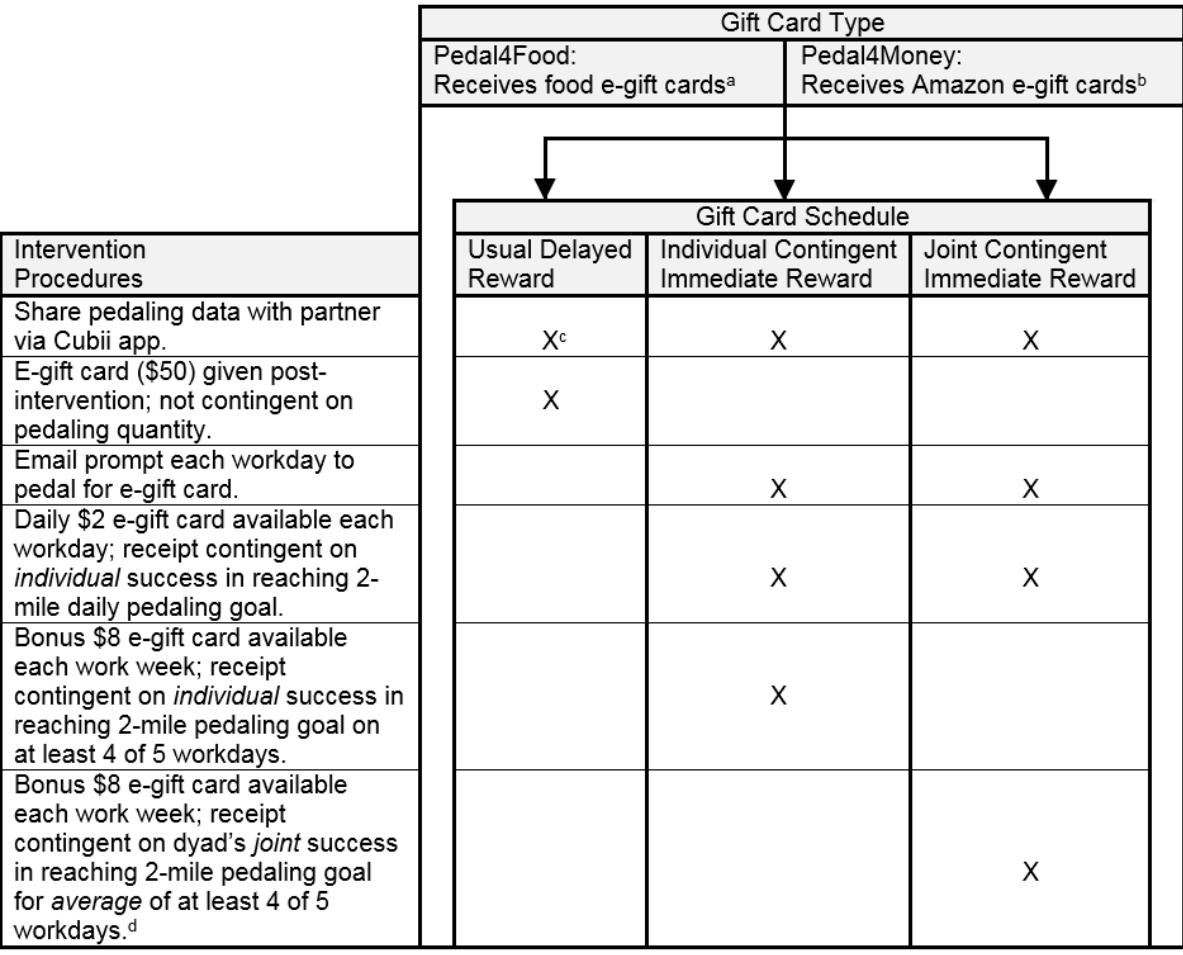
Figure 3. Randomized 2 (gift card type) by 3 (gift card schedule) factorial study design. a: In the Pedal4Food—Individual or Joint Contingent Immediate Reward groups, the $2 e-gift card covers a beverage (standard small coffee, tea, or bottled water), and the $8 e-gift card covers a meal (any combination of a salad, wrap, sandwich, soup, or bottled water) redeemable at the Hershey Medical Center-operated cafeterias, Au Bon Pain and Starbucks); the Usual Delayed Reward group receives $50 of combined beverage and food e-gift cards proportional in quantity to the other 2 groups; b: In the Pedal4Money—Individual or Joint Contingent Immediate Reward groups, the $2 and $8 e-gift cards can be applied toward any purchase on Amazon; the Usual Delayed Reward group receives incentives combined as a $50 Amazon e-gift card; c: The symbol “X” indicates that an intervention procedure was administered for the designated study group; d: This bonus is received if both partners meet pedaling goals on at least 4 workdays, or if one partner meets pedaling goals for 3 workdays and one meets goals for 5